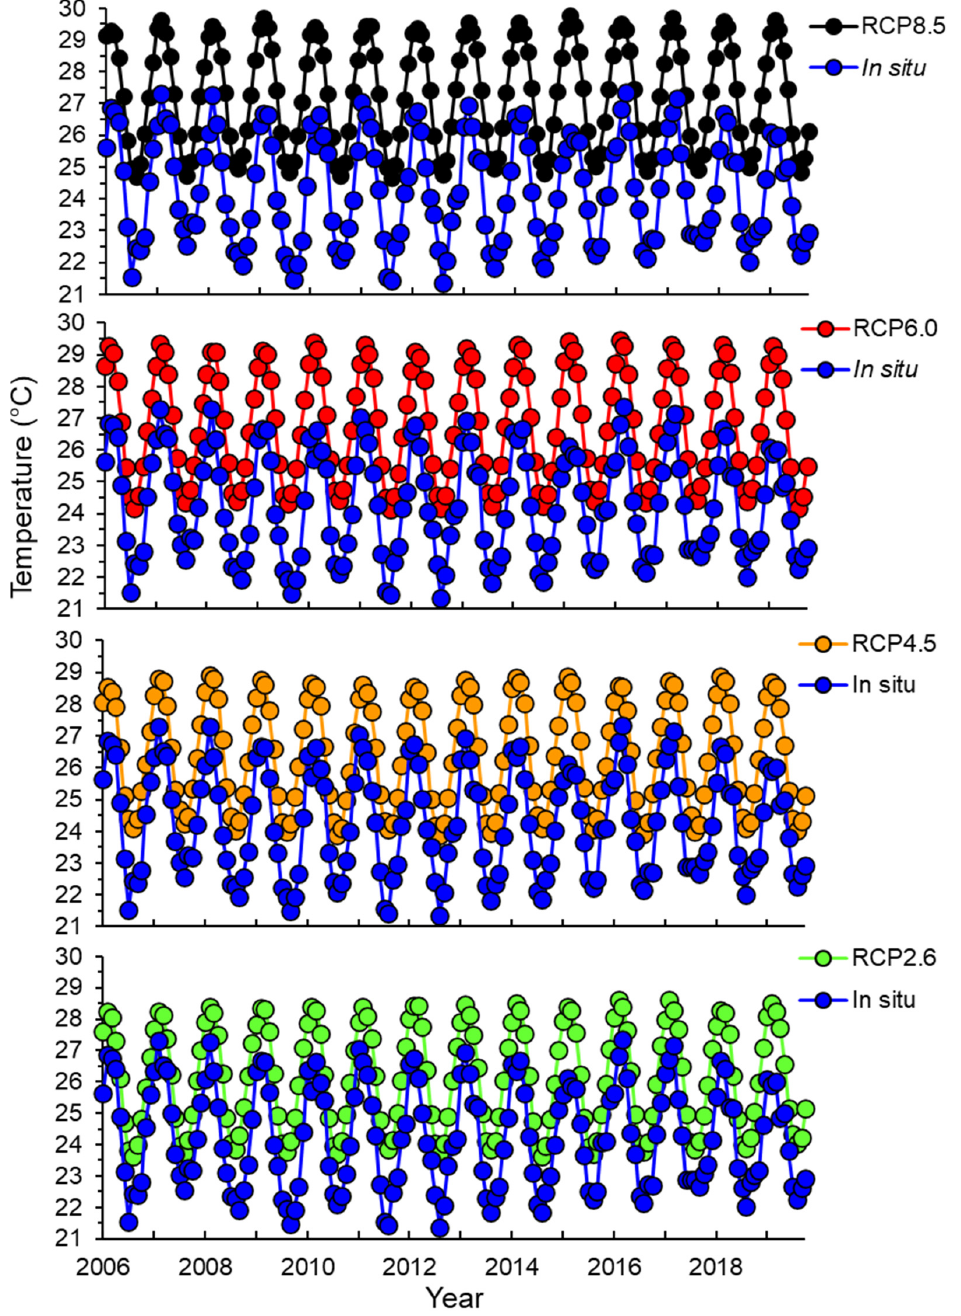
Figure 3. Temperature timeseries from 2006 based on monthly data derived from in situ measurements and Representative Concentration Pathway (RCP) models for Nine-mile Reef, Sodwana Bay, South Africa. Monthly in situ data are at least a degree centigrade cooler compared to the different monthly temperatures derived from the various RCP models.